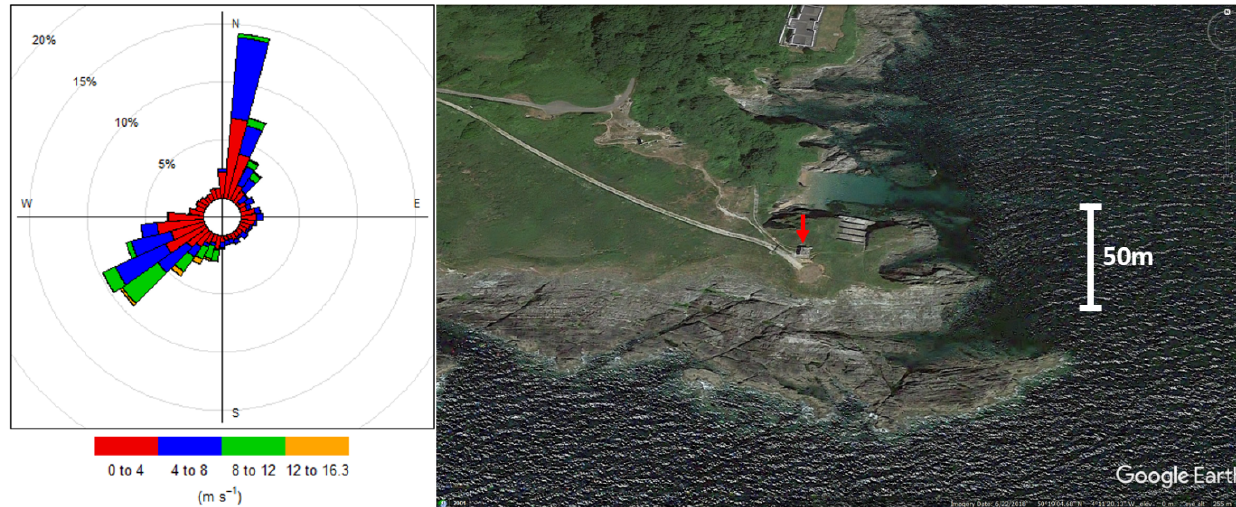
Figure 1. Wind directions and speeds at the PPAO during the study period (left). Radial percentage values indicate the portion of all observed wind that fell within a given sector. Local geography of the PPAO (right). © Google Earth.